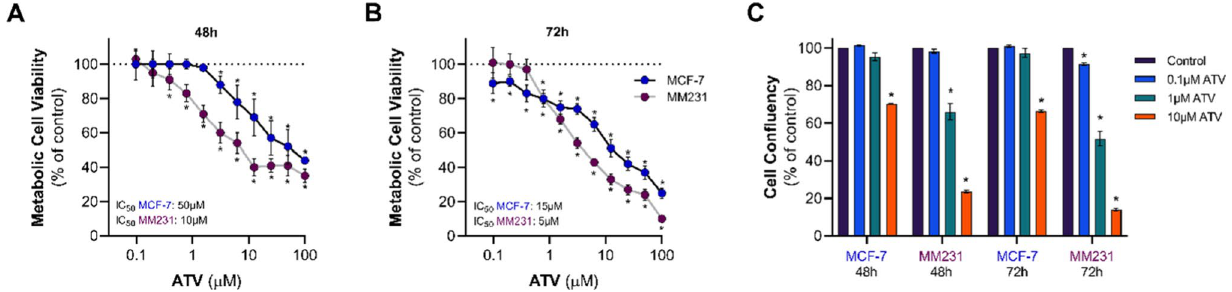
Fig. 2 Cytotoxic effects of ATV in MCF-7 and MDA-MB-231 cells. ATV cytotoxicity on MCF-7 and MDA-MB-231 (MM231) cells cultured in DMEM containing 10% FBS, and IC values were calculated by MTT assay at A 48 h and B 72 h. C Effect of ATV treatment on cell confluency 50 determined by IncuCyte and data presented as fold change to time-matched vehicle control. Data are expressed as mean ± SEM from three independent experiments performed in quadruplicate ( A & B ) or with six technical replicates ( C ). *p < 0.05 vs. Control (vehicle-treated cells) within each experiment by two-way ANOVA followed by Bonferroni post hoc test ( A & B ) or one-way ANOVA followed by Dunnett’s post hoc test ( C ). A & B IC values were calculated by nonlinear regression of log(inhibitor) vs. response using least squares as fitting method in a 4 50 parameters calculation with variable